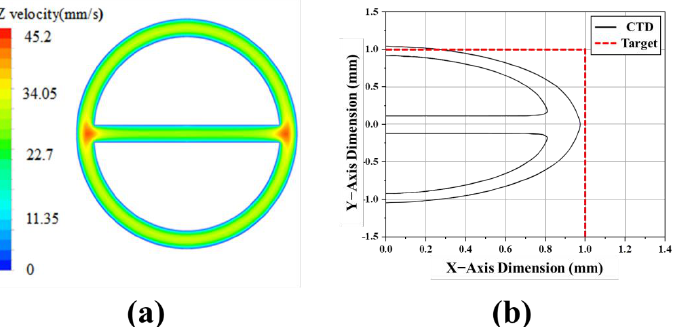
Figure 4. Result of numerical analysis for circular tip and die (CTD): ( a ) Velocity contour at end of tip and die; and ( b ) specification of extrudate tube for measurement of deformation ratio.